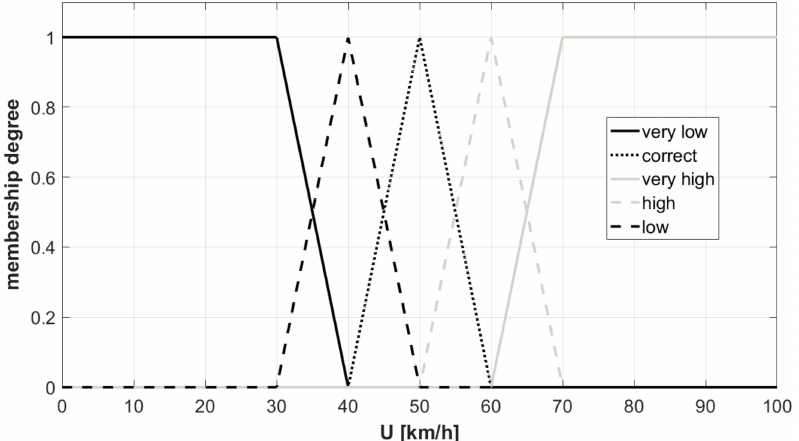
Figure 10. Membership degree of the input variable airspeed U associated with fuzzy sets: very low, low, correct, high, very high.